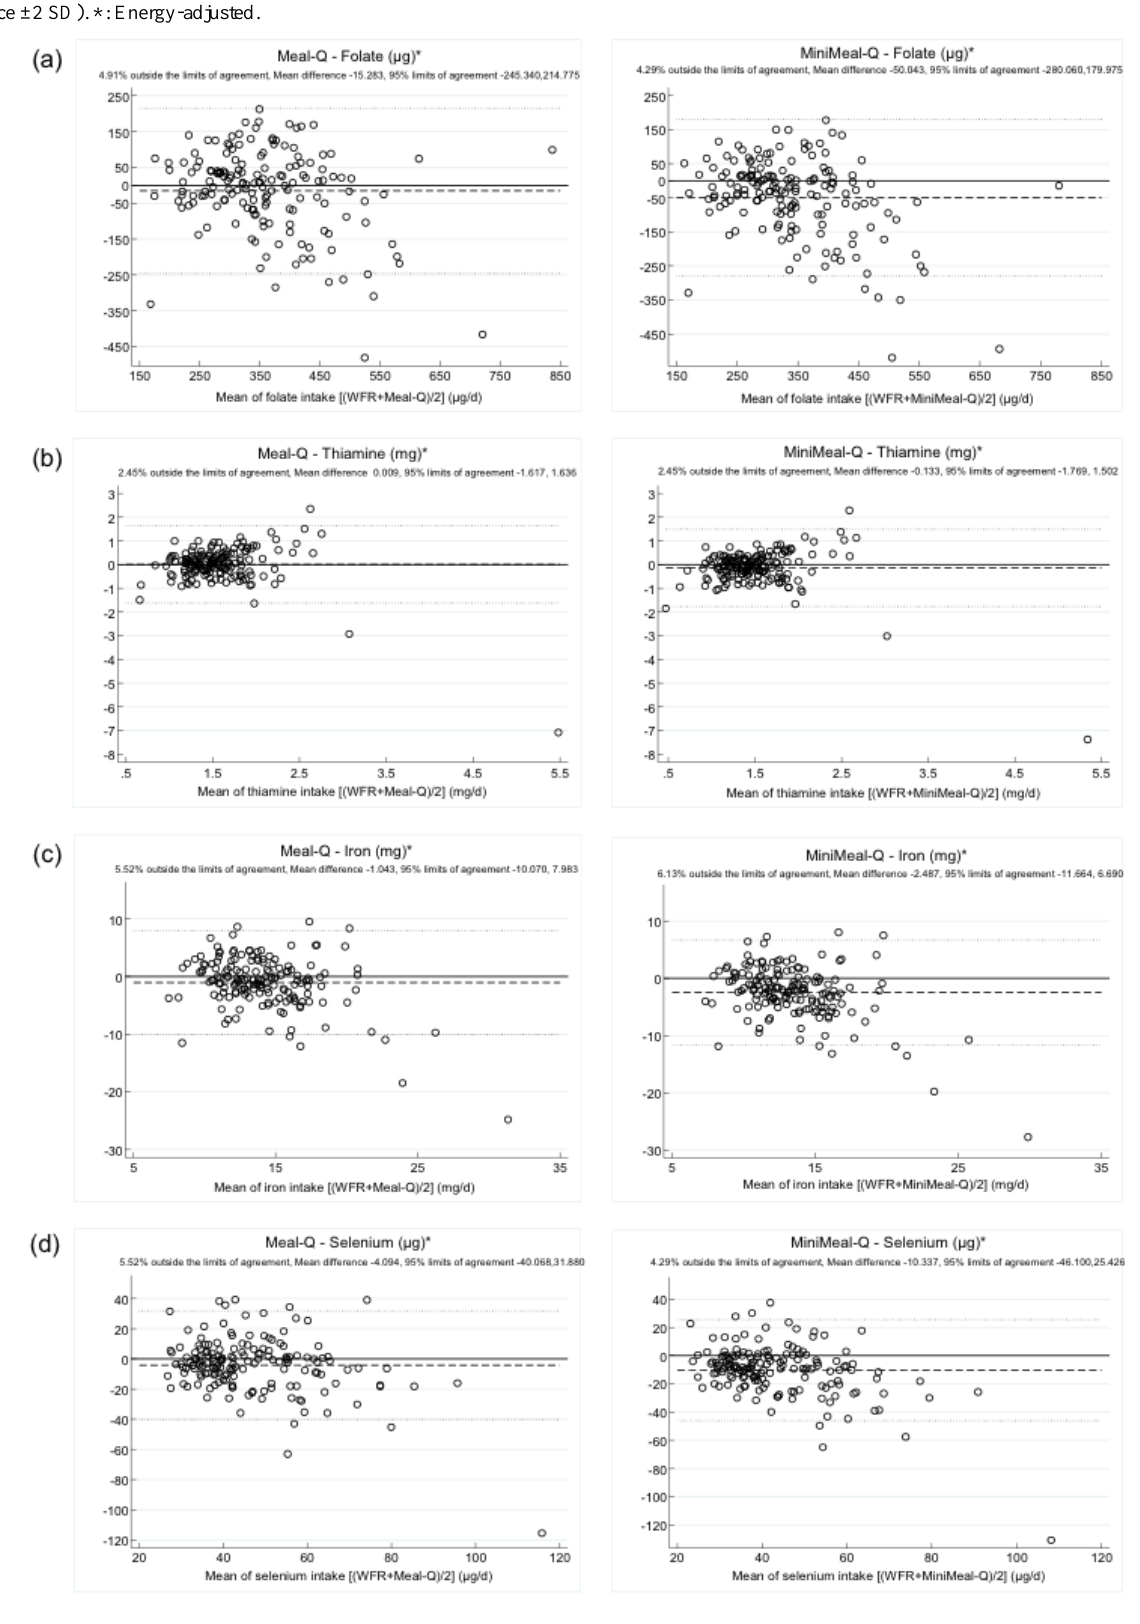
Figure 3. Bland-Altman plots with the weighed food record (WFR), Meal-Q, and MiniMeal-Q for (a) folate, (b) thiamine, (c) iron, and (d) selenium (N=163). Differences in intake between the WFR and the questionnaires are plotted against the mean of the 2 methods. The solid line indicates the reference line of zero difference. The long-dashed line shows the mean difference. The short-dashed lines show the 95% limits of agreement (mean difference ±2 SD). *: